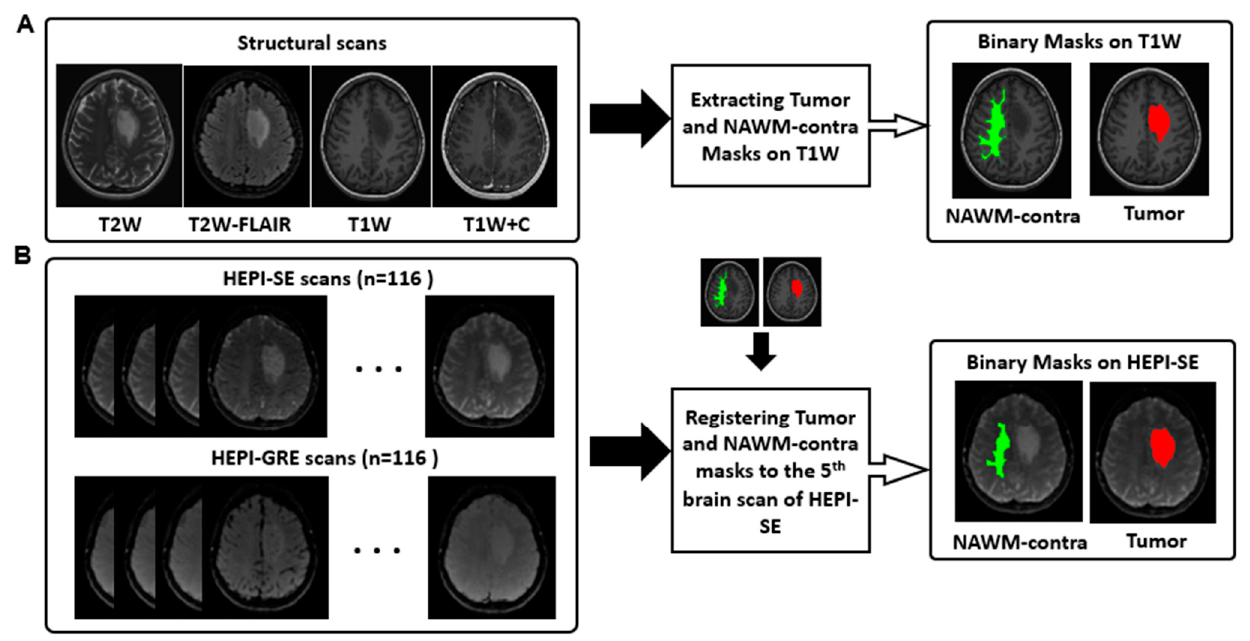
Figure 1. Preprocessing workflow. ( A ) T2-weighted (T2W), T2-weighted FLAIR (T2W-FLAIR), pre- contrast T1-weighted (T1W) and postcontrast T1-weighted (T1W + C) images are used for extracting binary masks of tumor (highlighted in red) and NAWM-contra (highlighted in green); ( B ) brain scans of HEPI-GRE and HEPI-SE; the generated binary masks of tumor (highlighted in red) and NAWM-contra (highlighted in green) are transferred from structural space to HEPI space. The overlaid NAWM-contra and tumor masks have a numerical value of one, with distinct colors employed solely to enhance visual differentiation.